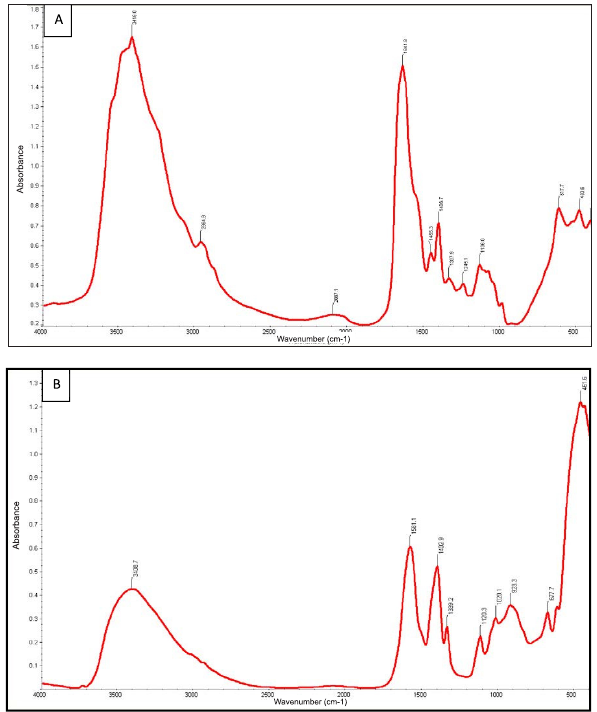
Fig. 6. FTIR spectra of (A) pyoverdine with zinc (0 min) and (B) after bio-reduction (24 h).